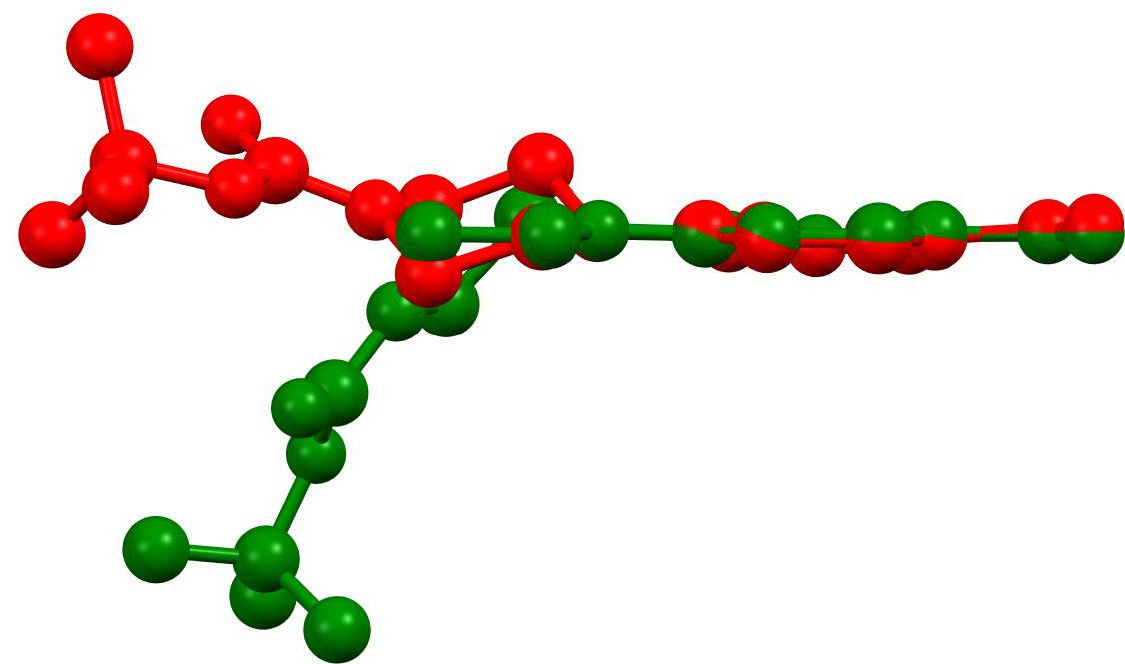
Figure 2. An overlay of the molecular structures of the monoclinic (red) and orthorhombic (green) polymoprhs.